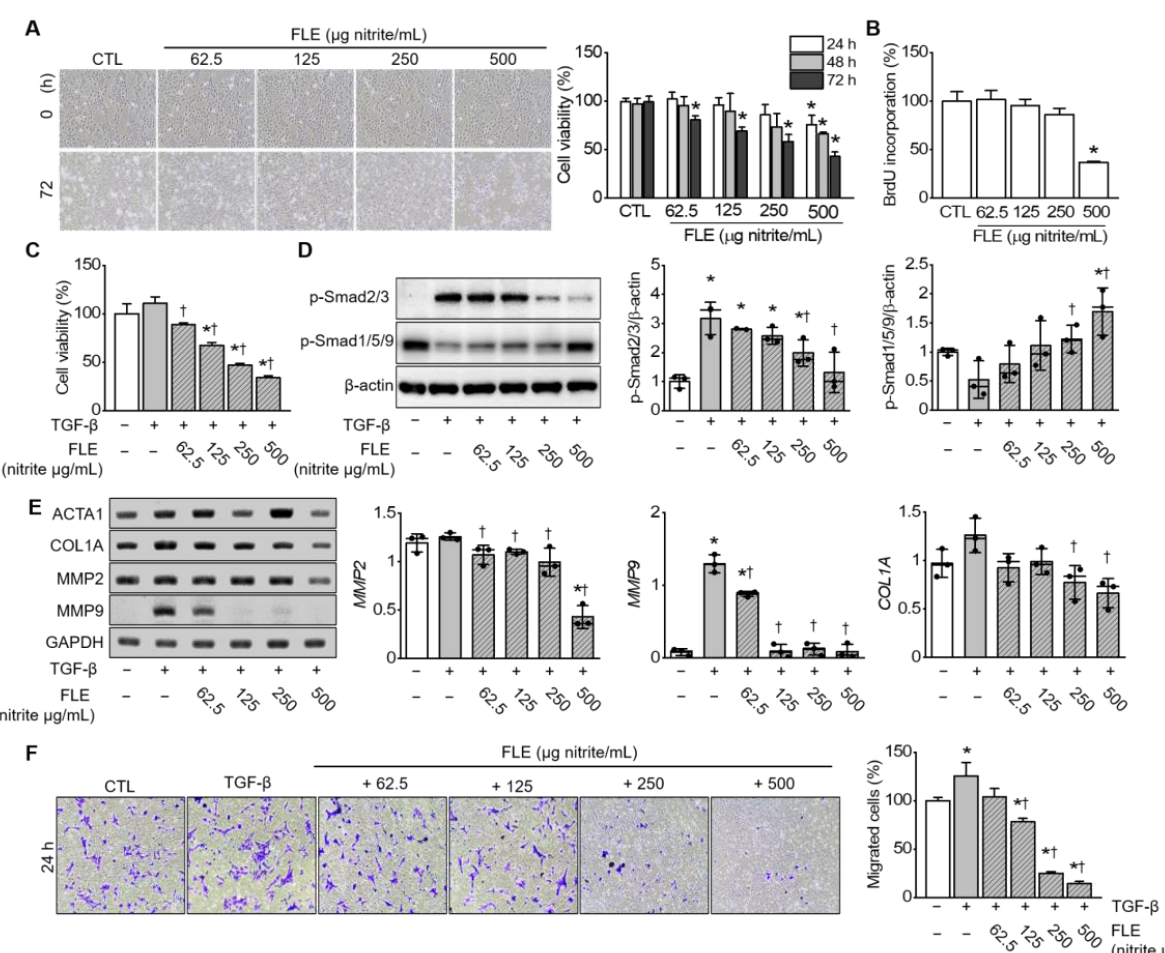
Figure 4. FLE suppresses the TGF- β /Smad signaling pathway in TGF- β -stimulated MH7A cells. ( A ) Representative morphological images of MH7A cells treated with FLE. Cells ( n = 3) were exposed to various FLE concentrations (62.5, 125, 250, and 500 µ g nitrite/mL) for 24, 48, and 72 h. Viability was measured using 3-(4, 5-dimethylthiazol-2-yl)-2, 5-diphenyltetrazolium bromide (MTT) assays. ( B ) 5-Bromo- 2′ -deoxyuridine (BrdU) was incorporated into MH7A cells after FLE treatment for 72 h ( n = 3). ( C ) Effect of FLE and TGF- β (10 ng/mL) on MH7A cell viability at 72 h ( n = 3). ( D ) Western blotting of phospho-Smad2/3 and phospho-Smad1/5/9 expression in MH7A cell lysates after 72 h treatment with TGF- β ( n = 2 − 3). ( E ) RT-PCR detection of ACTA1 , COL1A , MMP2 , and MMP9 mRNA in MH7A cells ( n = 3). ( F ) Representative microscopic images of results from transwell migration assays. Data are shown as means ± SD ( n = 3). * p < 0.05, compared to control (CTL). † p < 0.05, compared to TGF- β . The plus (+) sign represents a combination of FLE and TGF- β , as in +62.5, +125, +250, and +500. The minus ( − ) sign represents untreated samples.